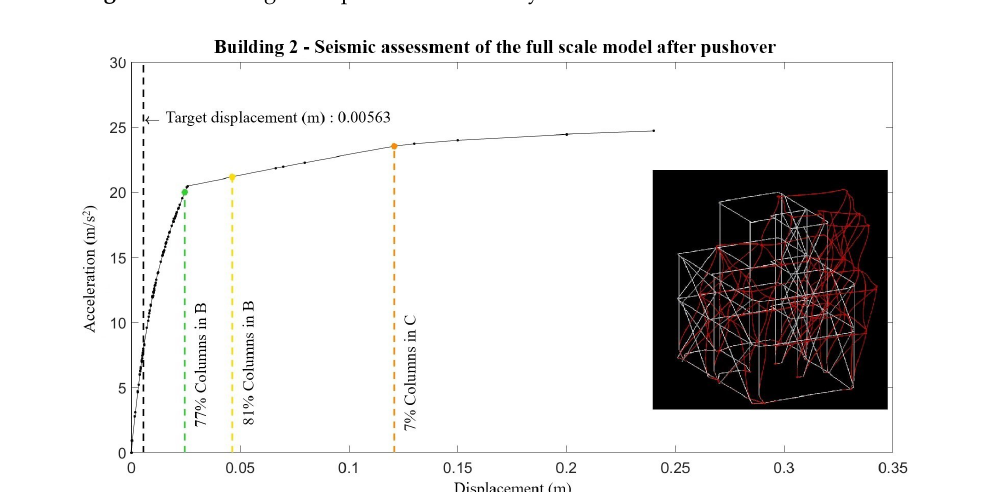
Figure 13. Building 2: Response estimation by method.